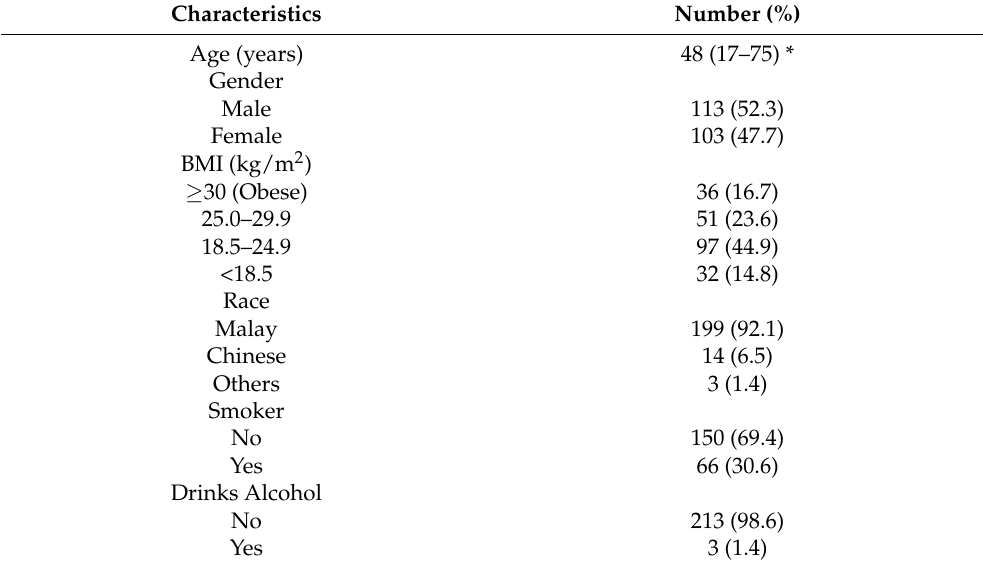
Table 1. Socio-demographic characteristics of the study population (n =216).